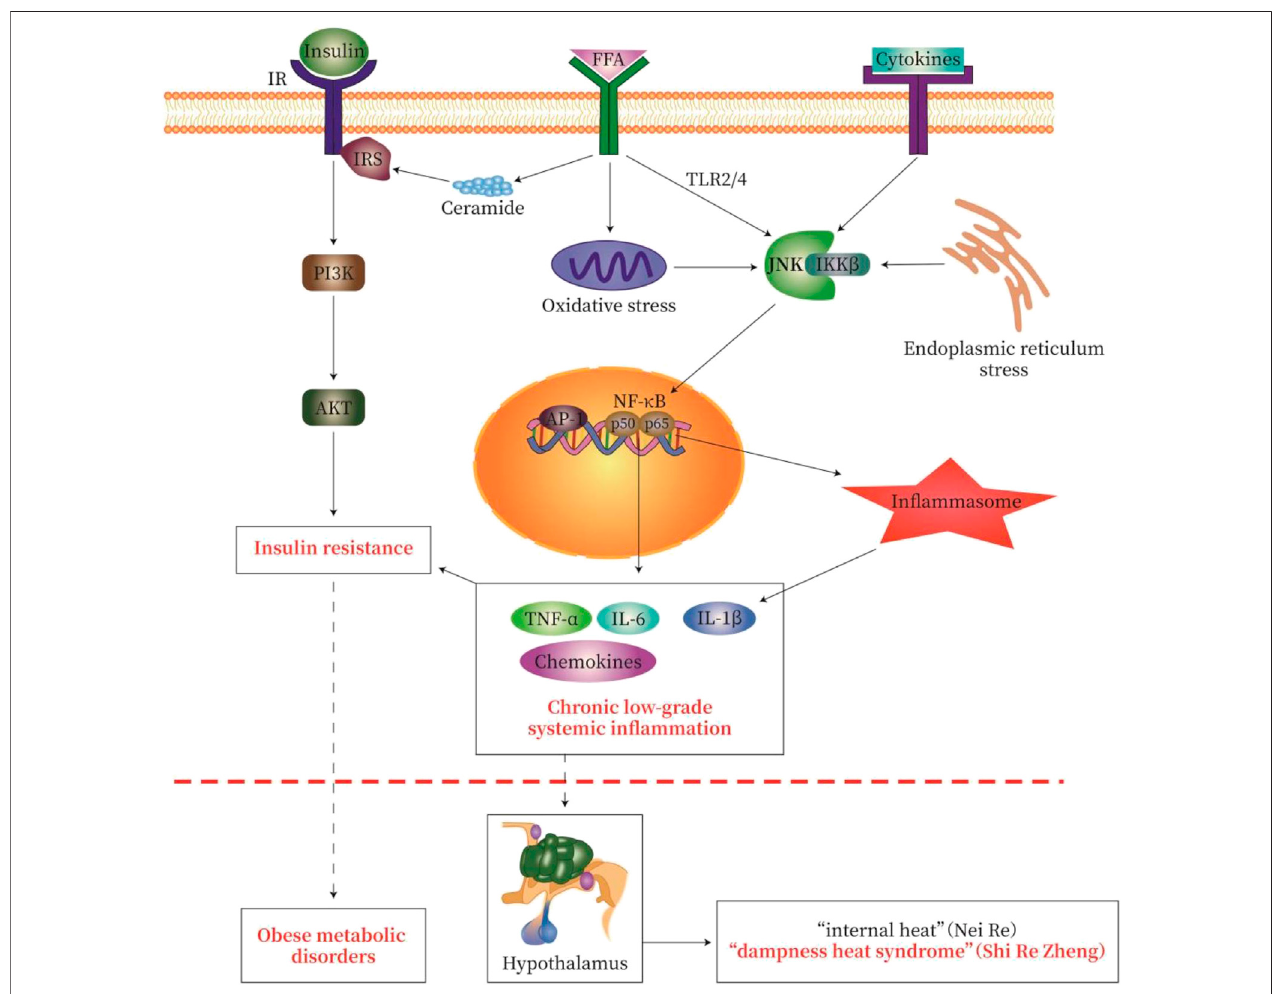
FIGURE3| Pathologicalpathwayof “ Lipid-toxicity In fl ammation ” or “ Dampness-heatSyndrome ”— InsulinResistance-Metabolicdisease. We try toexplainthe classic theory of TCM by using modern western medicine (MWM). In obese patients with dampness heat syndrome, a large amount of free fatty acid (FFA) is producedinthebody,causinglipotoxicity,called “ lipidtoxicity or FeiDu ” . AlargeamountofFFAmay causechroniclow-gradesystemicin fl ammation,whichcauses “ heat ” as one symptom of in fl ammation. These may be the modern medical interpretation of “ fat makes people hot ” in dampness heat syndrome. The severity ofobesity-typemetabolicdisorders(diabetes,fattyliver,obesity)re fl ectsthedegreeofin fl ammatoryinjury.Theactivationofvariousin fl ammatorysignalingcascades in chronic low-grade systemic in fl ammation leads to the activation of NF- κ B, Jun N-terminal kinase (JNK), and in fl ammatory bodies, thereby causing insulin resistance.Thecommon pathologicalfeatureofobesemetabolicdisordersischroniclow-gradein fl ammationandinsulinresistance.IR,insulinreceptor;IRS,insulin receptor substrate; FFA, free fatty acids. The signal pathway map here was generated by Adobe Illustrator software.